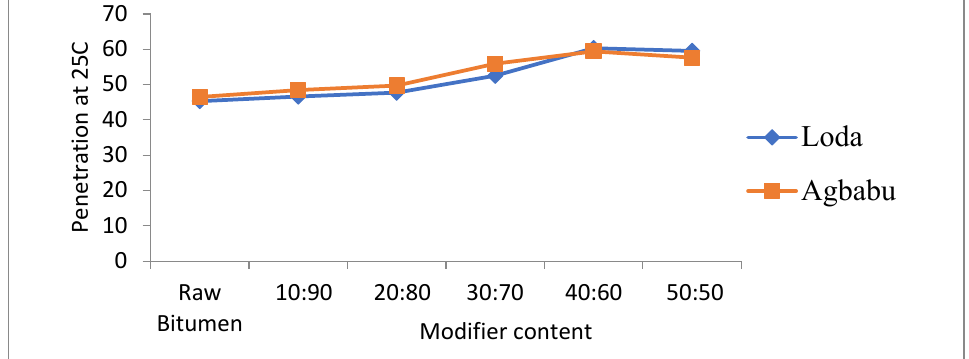
Fig. 5: Penetration in raw bitumen and modifier content